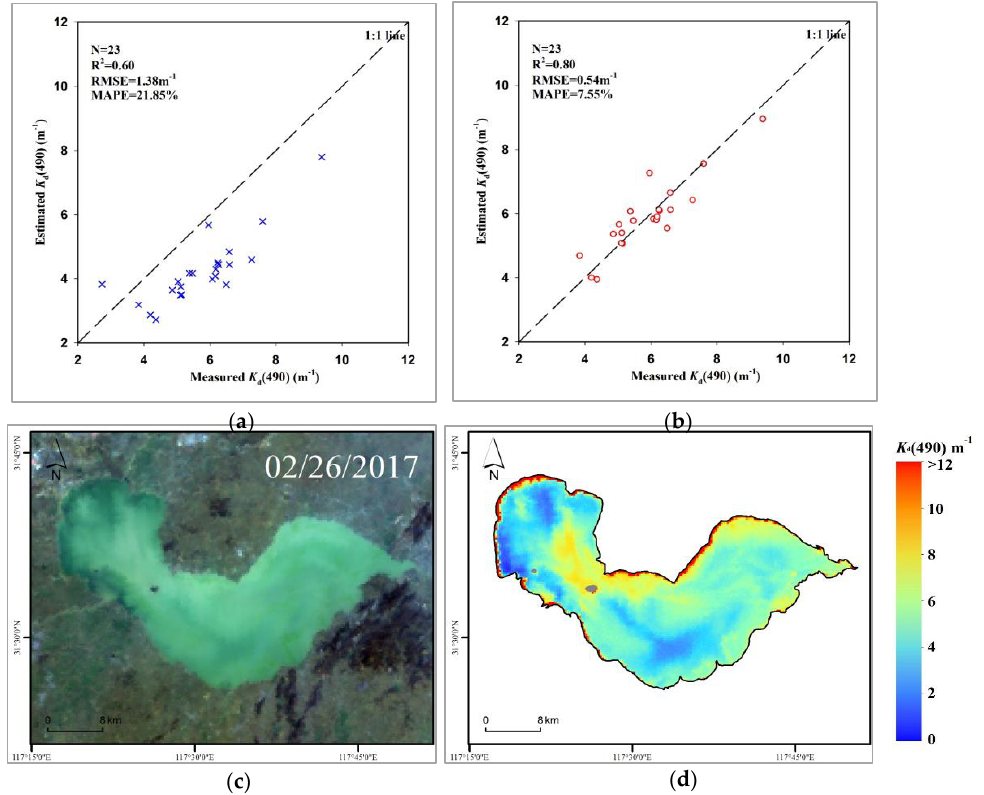
Figure 11. ( a , b ) Validation of the algorithm for estimating K d (490) in Lake Chaohu using the OLCI-derived R rs with the default parameterization and local parameterization; ( c , d ) OLCI RGB and OLCI-derived K d (490) distributions in Lake Chaohu on 26 February 2017.